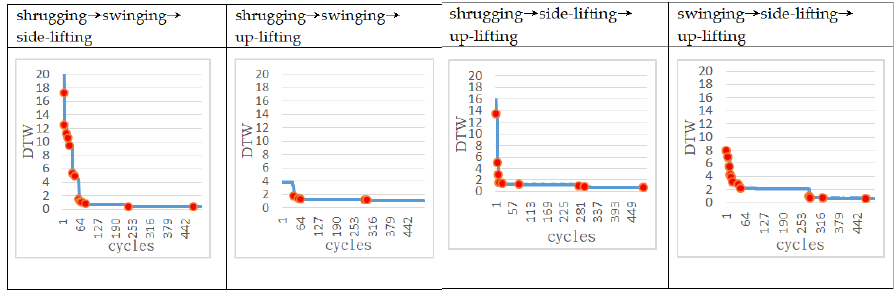
Figure 11. Learning progress of the ANM system for complex actions using three motors.